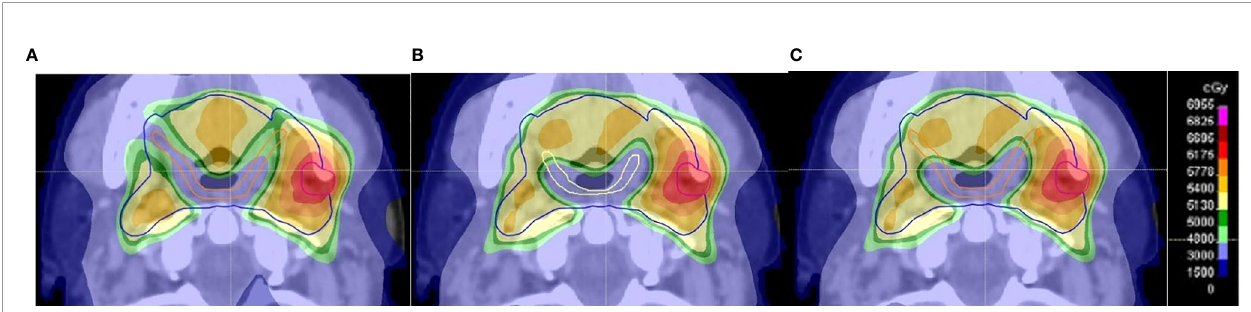
FIGURE 1 | Example of evaluation of dose delivered to pharyngeal constrictor muscle (PCM) based on clinician contours on an axial CT slice. (A) The GS Do-IMRT plan based upon the gold standard (GS) superior and middle PCM (SMPCM) (orange) and GS IPCM contour was created to record the dose-volume histogram (DVH) for this SW-OAR; (B) shows a clinician Do-IMRT plan that was generated using the clinician ’ s SMPCM (yellow) and IPCM delineation to derive the relevant dose metrics; (C) GS SMPCM and GS IPCM contour was superimposed on the clinician ’ s Do-IMRT plan in (B) to allow their DVHs to be derived. This was then compared to the original DVH obtained in (A) . The presence of variation between the GS and clinician contour, as in this slice, would highlight differences in dose delivered. In this example, it can be seen that there was less sparing of GS SMPCM laterally on clinician Do-IMRT plan compared to GS